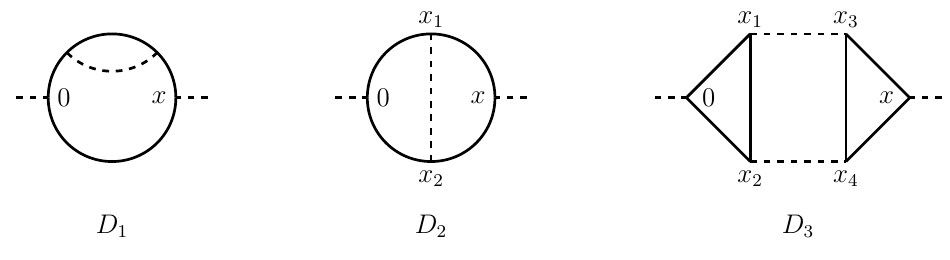
Figure 5 . The three position space diagrams that contribute to 1 =N corrections to the anomalous dimension of the (cid:27)